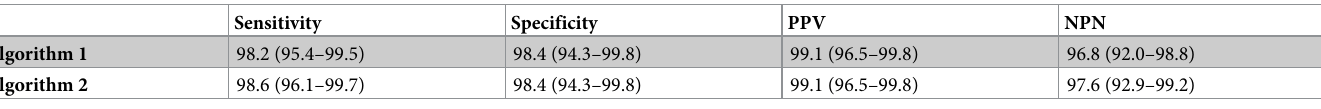
Table 6. Diagnostic accuracy of algorithm 1 or 2 compared with expert microscopy (gold standard) for the diagnostic of Plasmodium falciparum malaria of 344 conclusive diagnostic test results obtained with sequential reading of two-line malaria RDTs.